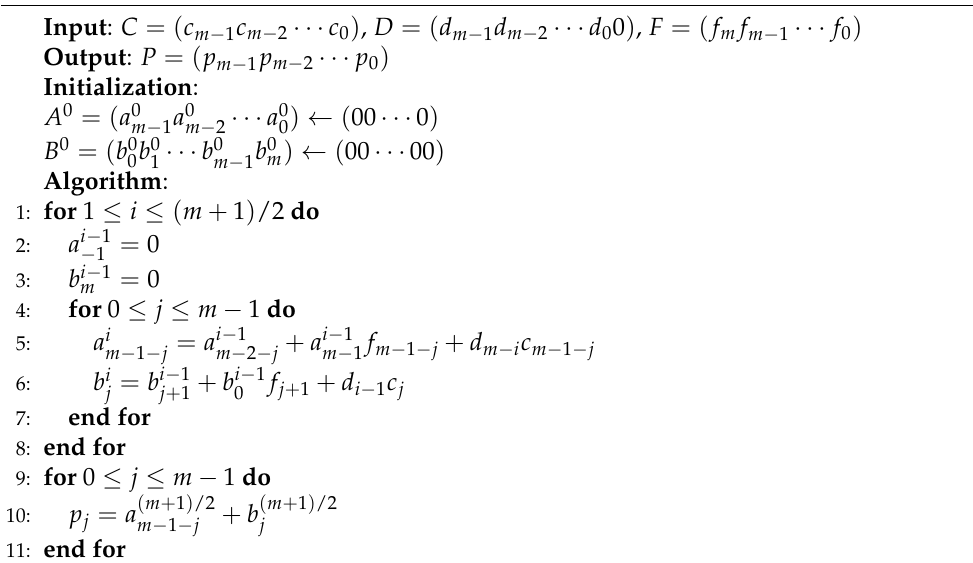
Algorithm 2 Montgomery Multiplication Algorithm in the bit-level